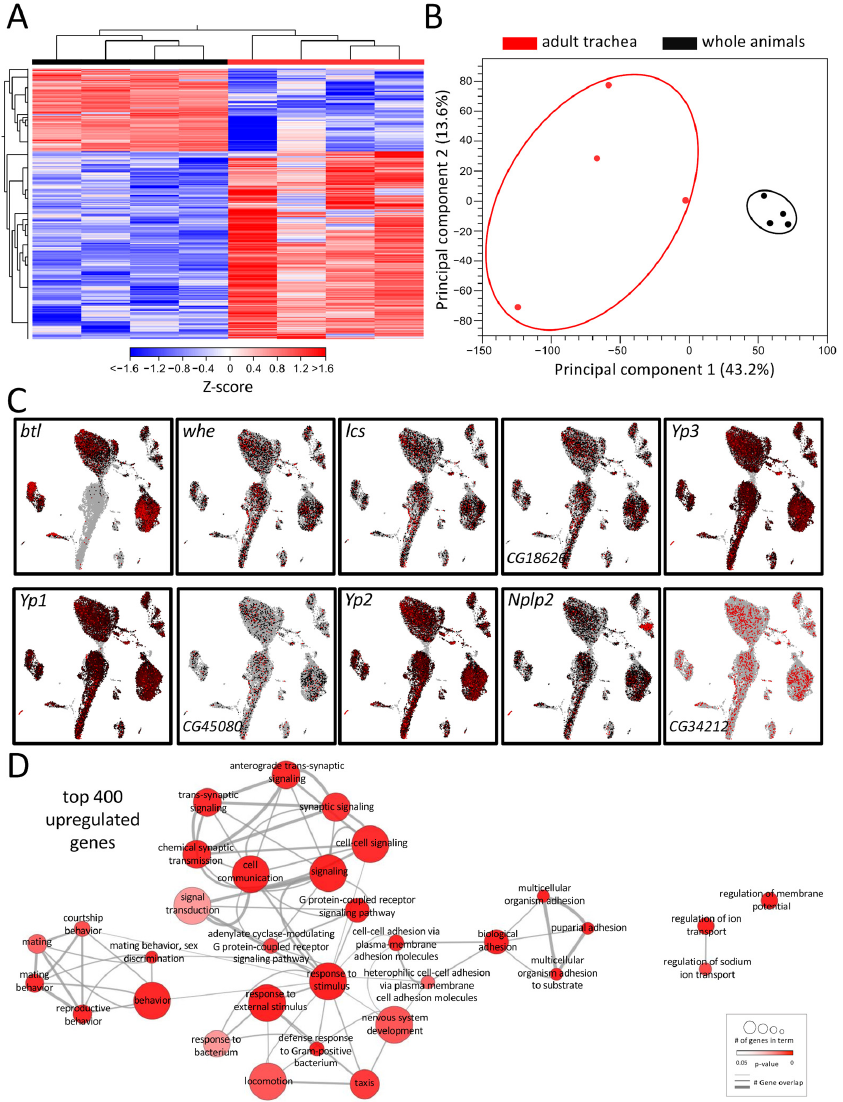
Figure 1. Transcriptomic analyses of adult respiratory epithelia compared to whole flies. ( A ) Heatmap of all differentially expressed genes (DEGs) between adult trachea (red) and whole flies (black). DEG cutoff: fold-change > 1.5. ( B ) PCA of all replicates from adult trachea and whole flies. Circles were added manually. ( C ) Transcript plots of selected genes showing high abundances in the RNAseq experiments based on the Drosophila single-cell atlas https://scope.aertslab.org/#/FlyCellAtlas/FlyCellAtlas%2Fs_fca_biohub_trachea_10x_ss2.loom/gene, accessed 12 December 2022 [28]. ( D ) GO analysis with the top 400 upregulated DEGs with a cutoff value of FDR < 0.05. Node size represents the number of associated genes in the GO term. The node color represents the p -value. Edge appearance represents the number of shared genes between the GO terms.